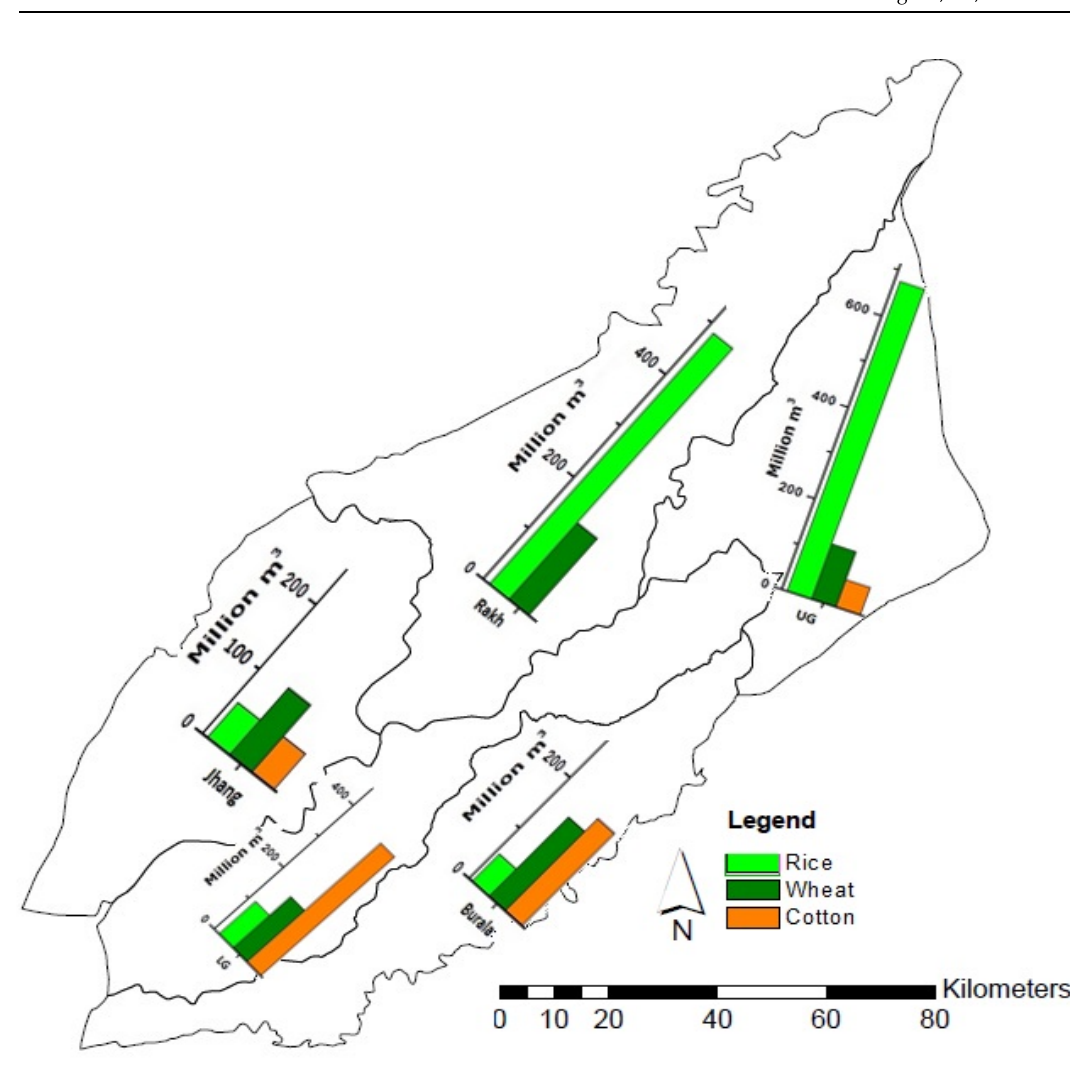
Figure 8. Water saving from PLL in the command area of LCC.